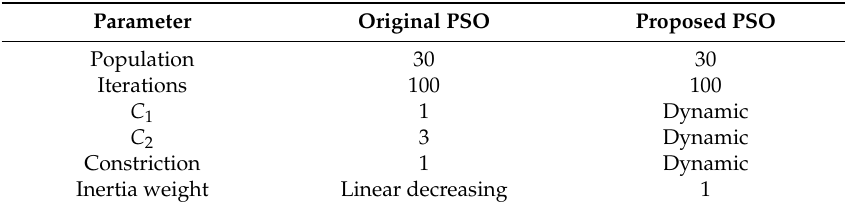
Table 5. Parameters for the PSO method original/proposed.